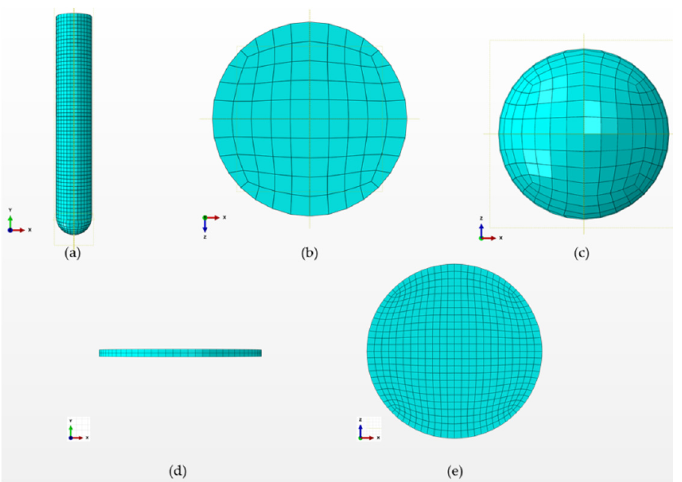
Figure 6. The views of the peeler grid: ( a – c ) The peeler grid of hemisphere target; ( d , e ) the peeler grid of the flat plate target.